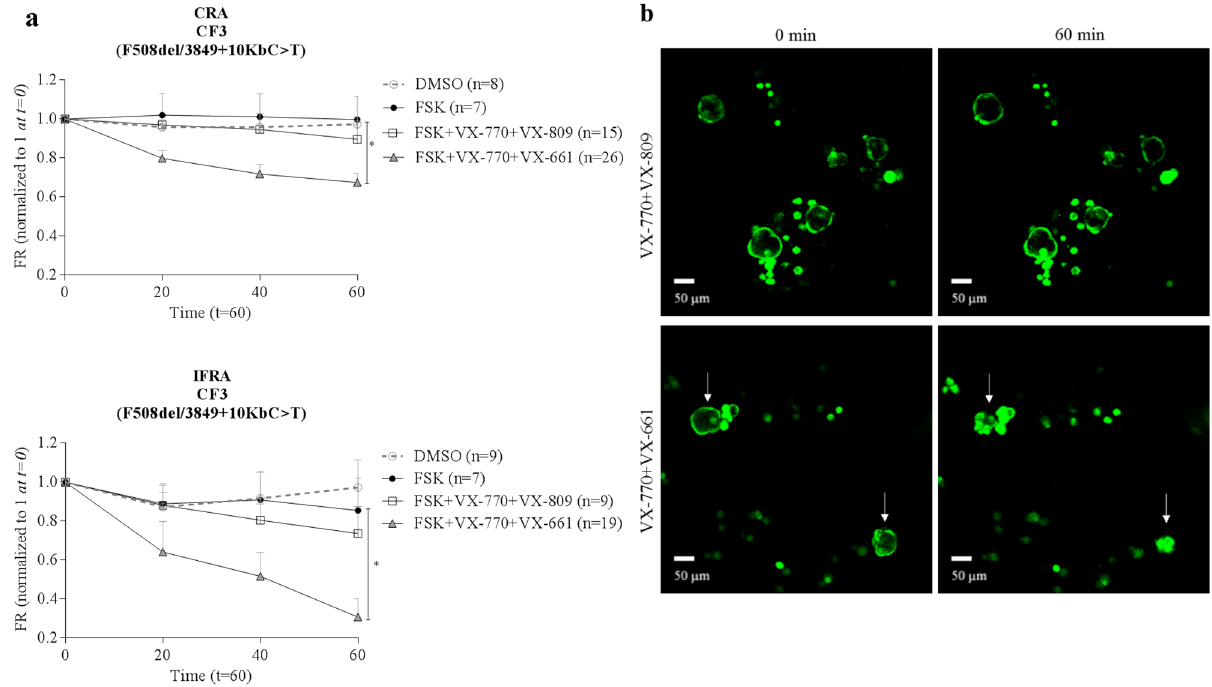
Figure 6. Pharmacological response in nasospheroids from patient CF3. ( a,b ) Patient CF3, presenting F508del/3849 + 10KbC>T genotype, showed no significant differences between FSK and VX-770 + VX-809 administration (CRA p = 0.2978, IFRA p = 0.5848) after 60 min of follow-up while a significant response was seen in presence of the VX-770 + VX-661 combination in comparison with only FSK (CRA * p = 0.0104, IFRA ** p = 0.0047) ( a,b ). Bars represent SEM. VX-incubation was always combined with FSK, Amiloride and IBMX. All CF nasospheroids were grown under condition 1. Image taken with confocal microscope LSM780 Zeiss, scale bar created with ImageJ/FIJI 31 and graphic created with GraphPad Prism version 6 33